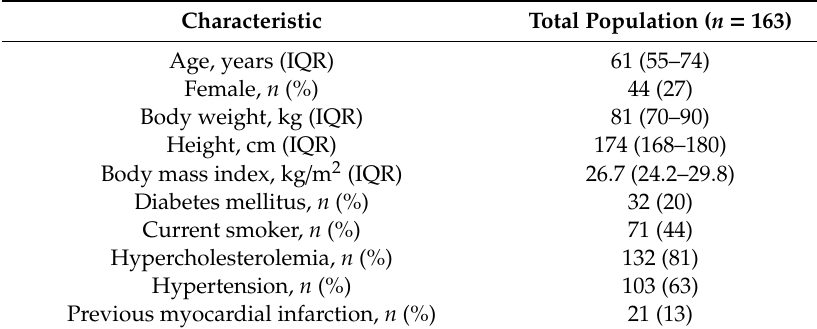
Table 1. Patient characteristics of the overall study